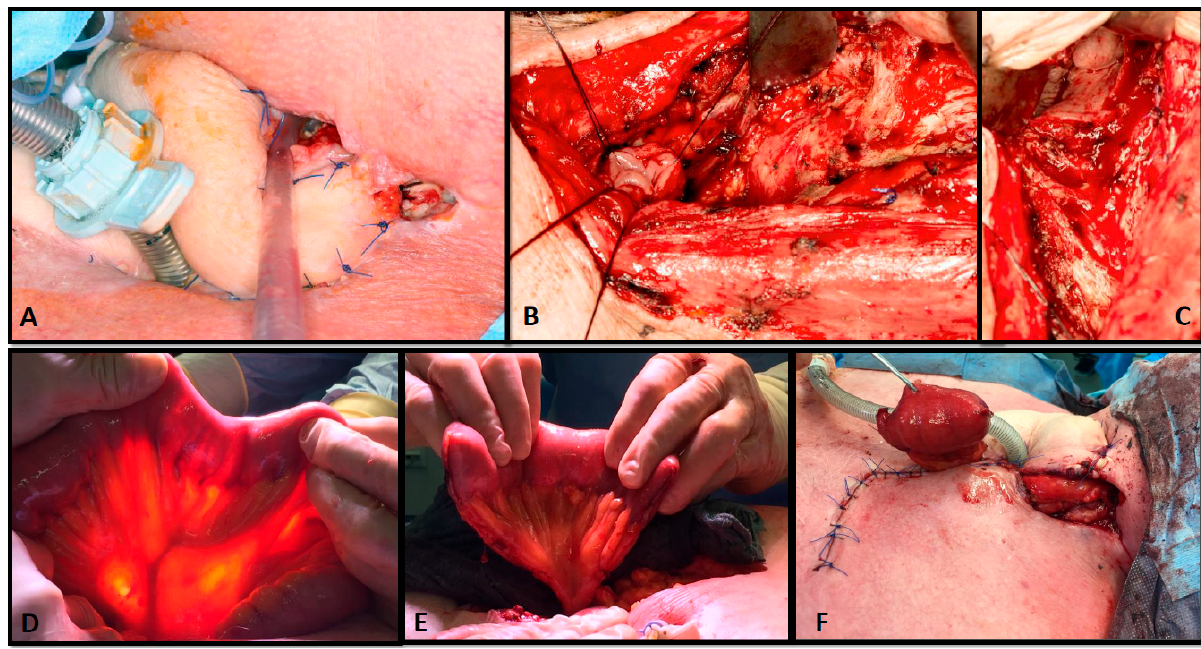
Figure 2. Sixty-year-old patient after reconstruction for a pharyngotracheal fistula after pharyngolaryngectomy and chemoradiotherapy, which was initially treated using a pedicled pectoralis major muscle flap. A second reconstruction was required for persistent TEF ( A ). After debridement and dissection of the distal esophagus ( B ) and the proximal pharynx (( C ) arrow), reconstruction was planned using a free jejunum segment ( D , E ) that was anastomosed to the internal mammary vessels. The skin could not be closed and was left for healing by secondary intention ( F ). A remaining proximal pharyngocutaneous fistula was closed using an epithesis since the patient denied further